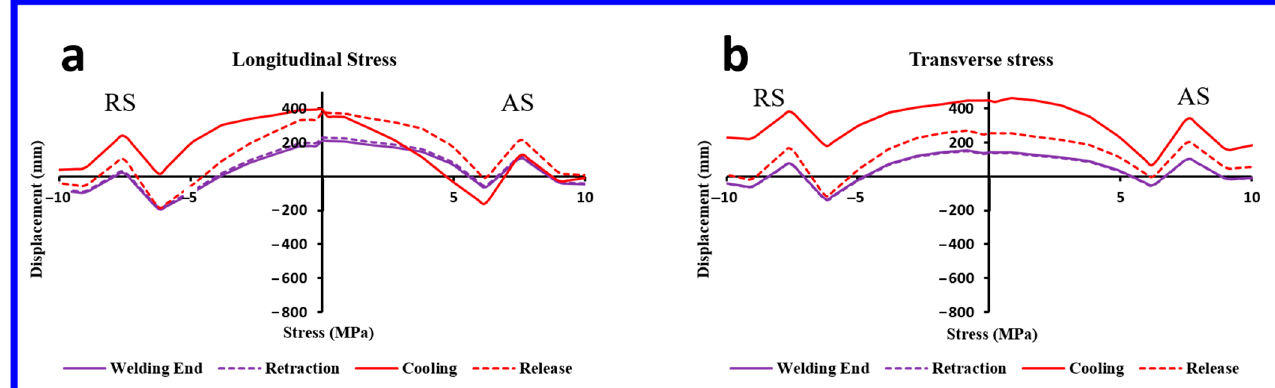
Figure 16. Variation of the stress during the FSW process for Test 2: ( a ) longitudinal and ( b ) transverse stress along the lateral path through the middle of the weld line at the surface.